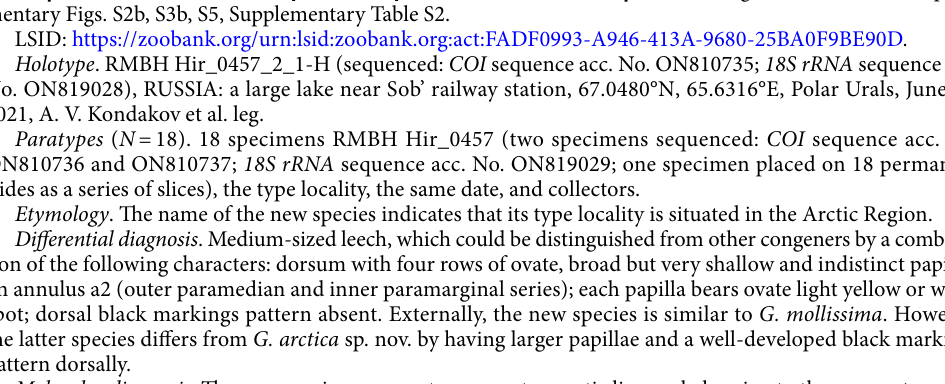
oration of ethanol-preserved animals: dorsum beige to light brown, with darker broad inner paramedian lines and light yellowish areas laterally and anteriorly; ovate light yellow or white spots at each papillae on annulus